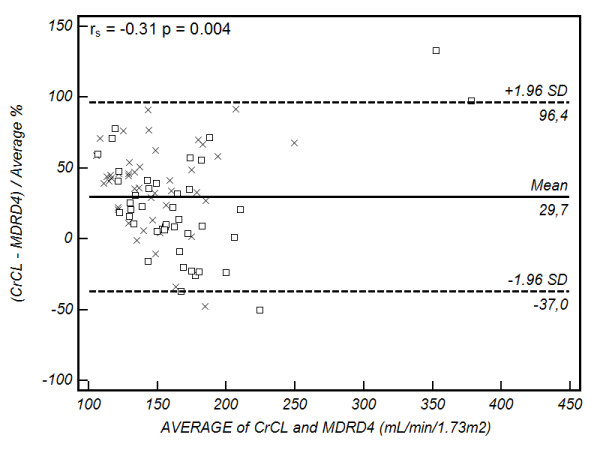
land-Altman plot of CLCR vs 4-variable modification of diet in renal disease equation. Comparison of the difference between the measured creatinine clearance (CLCR) and 4-variable modification of diet in renal disease equation (MDRD_4) (as a percentage) on the y-axis, versus the average value obtained on the x-axis. The solid line represents the bias (mean percentage difference obtained across the range of values), where as the dashed lines are the limits of agreement (+/- 1.96 × standard deviation (SD)). square, Australia cohort; cross, Portugal cohort. The Spearman correlation coefficient (rs) for the percentage difference and average value is provided in the top left hand corner (outliers excluded).